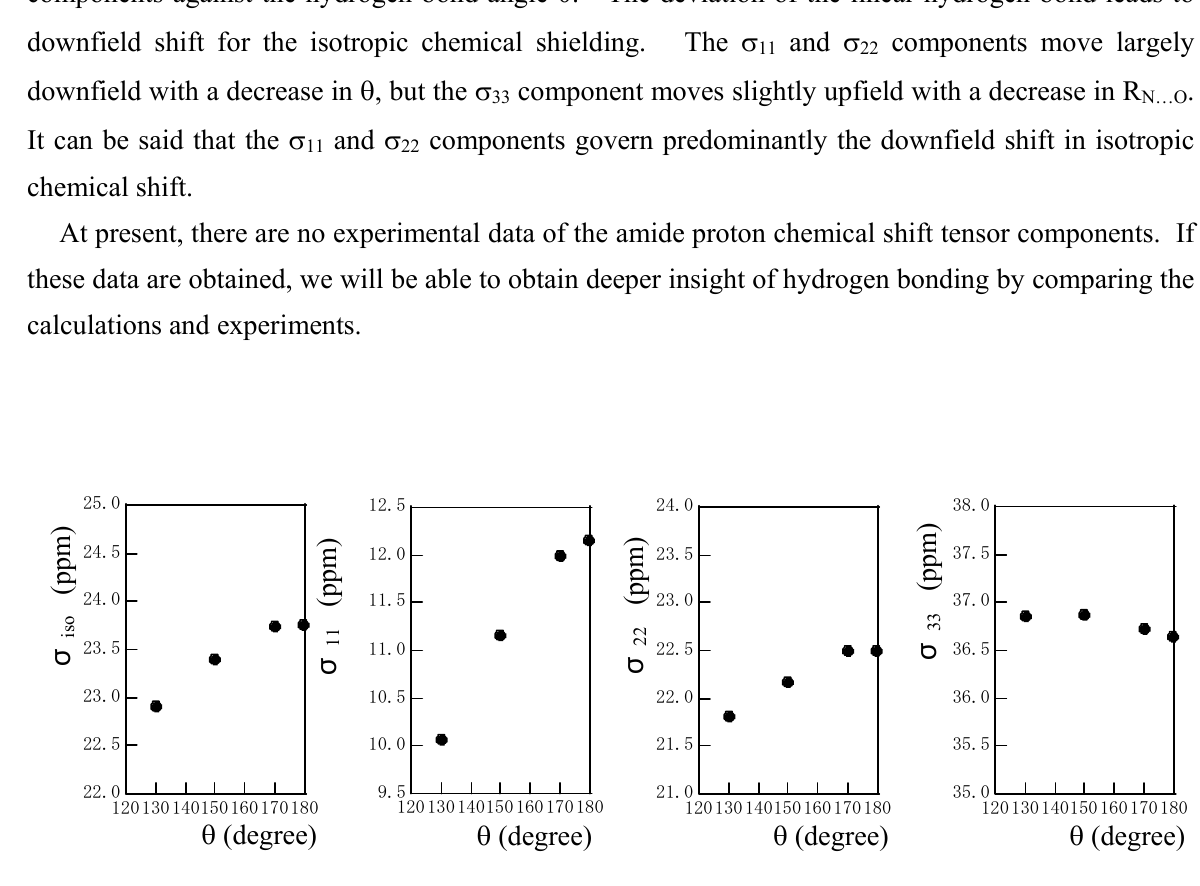
Figure 5. The plots of the angle Ψ between the amide N-H bond and the direction of the calculated 1 H chemical shielding tensor component σ of an N-methylacetamide hydrogen-bonded with a formamide against R Fig. 6 shows the plots of the calculated isotropic chemical shielding and chemical shielding tensor components against the hydrogen-bond angle θ . The deviation of the linear hydrogen-bond leads to